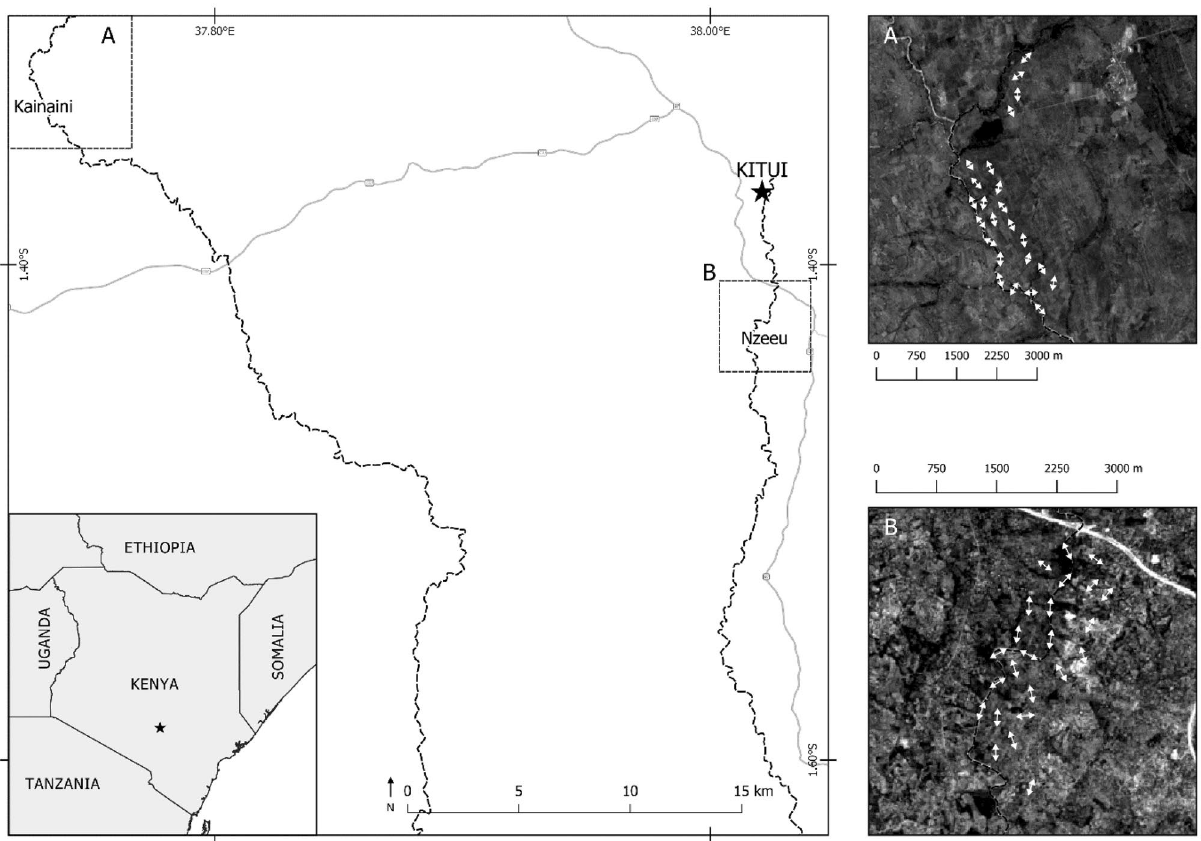
Figure 1. Location of our study region in Kenya (star in small inlaid map), enlarged map of our study region around Kitui, with the two study sites, Nzeeu River and Kainaini River, including all transects (aerial